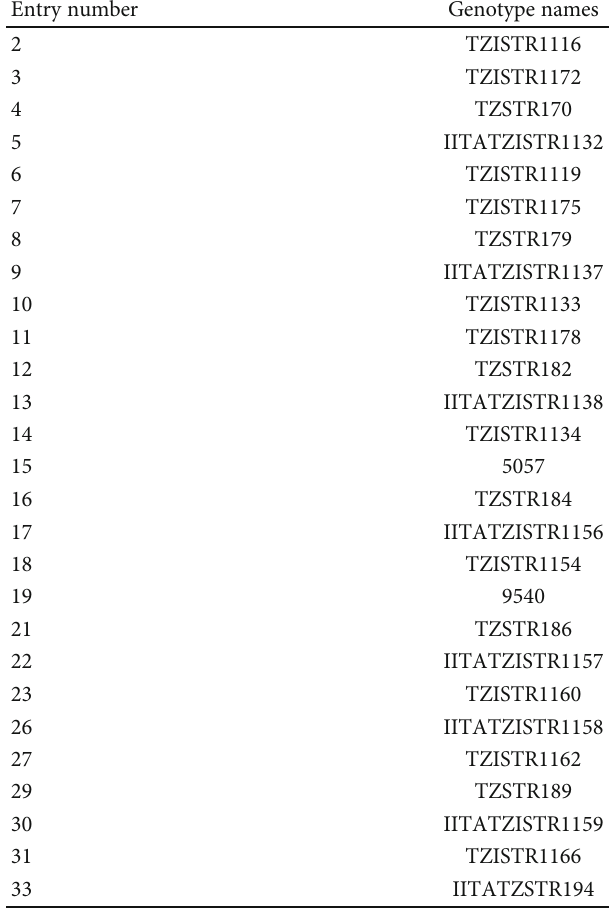
Table 1: Maize inbred lines from IITA used in the study. Table 2: Mean squares and genetic parameters for germination distance and germination